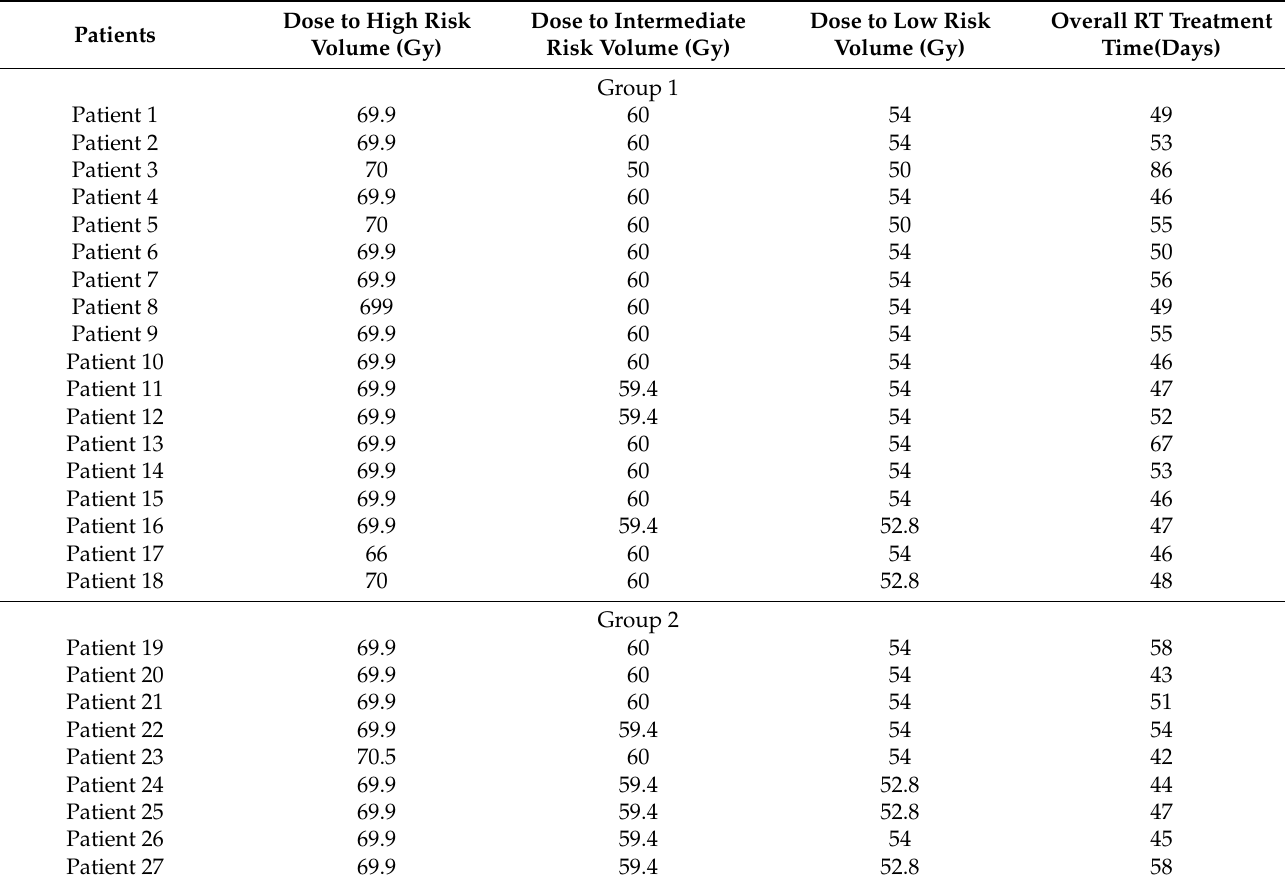
Table A3. Radiation dose data for the patients with mild xerostomia (Group 1) and moderate xerosto- mia (Group 2). Volumes have been stratified for oncologic risk (likelihood of persistence/recurrence of disease in the selected